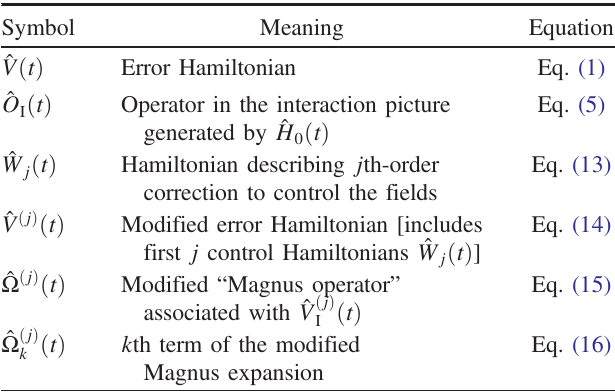
TABLE I. Definition of the most important